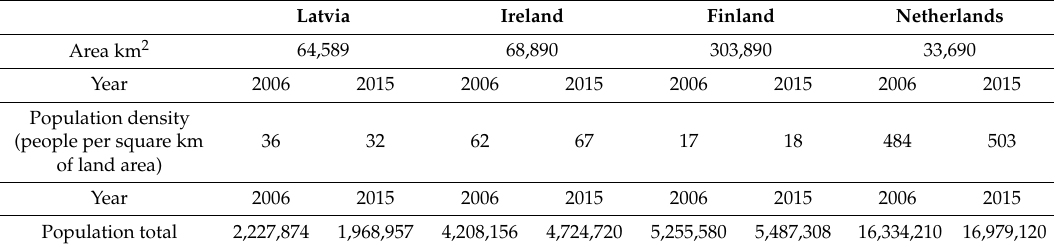
Table 1. Population of Latvia, Ireland, Finland and Netherlands in comparison (based on Worldbank [8], Eurostat [9]).